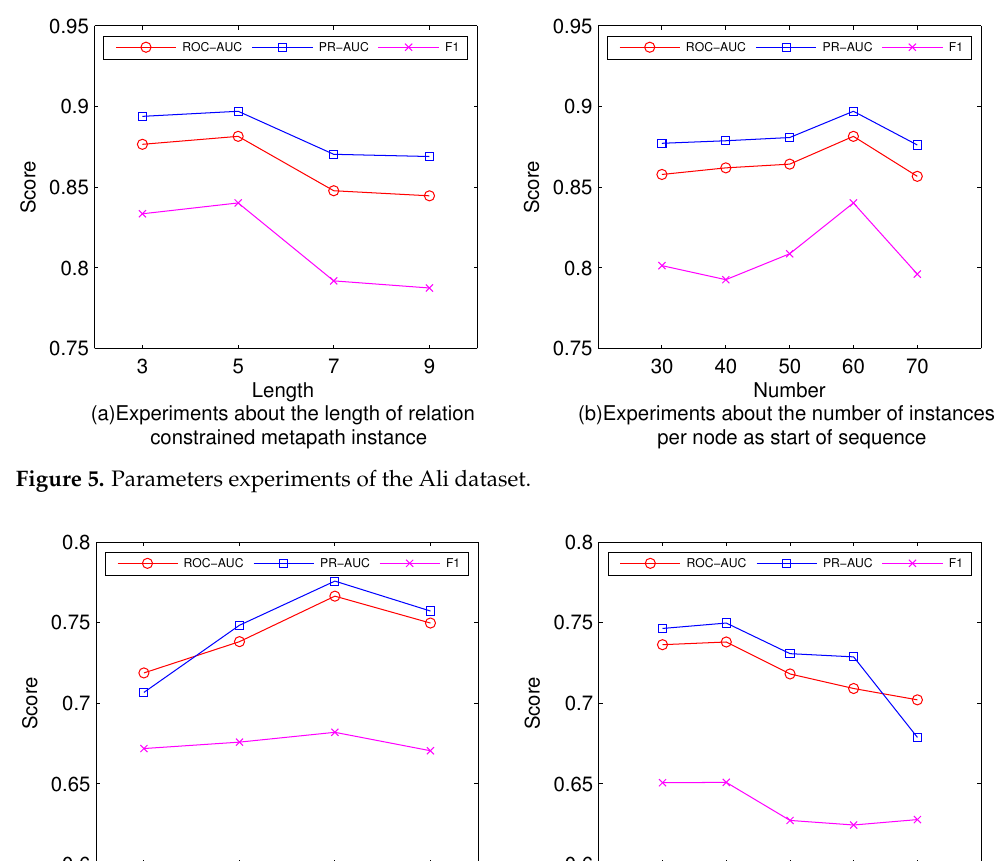
Figure 4. Parameters experiments of the YouTube dataset.